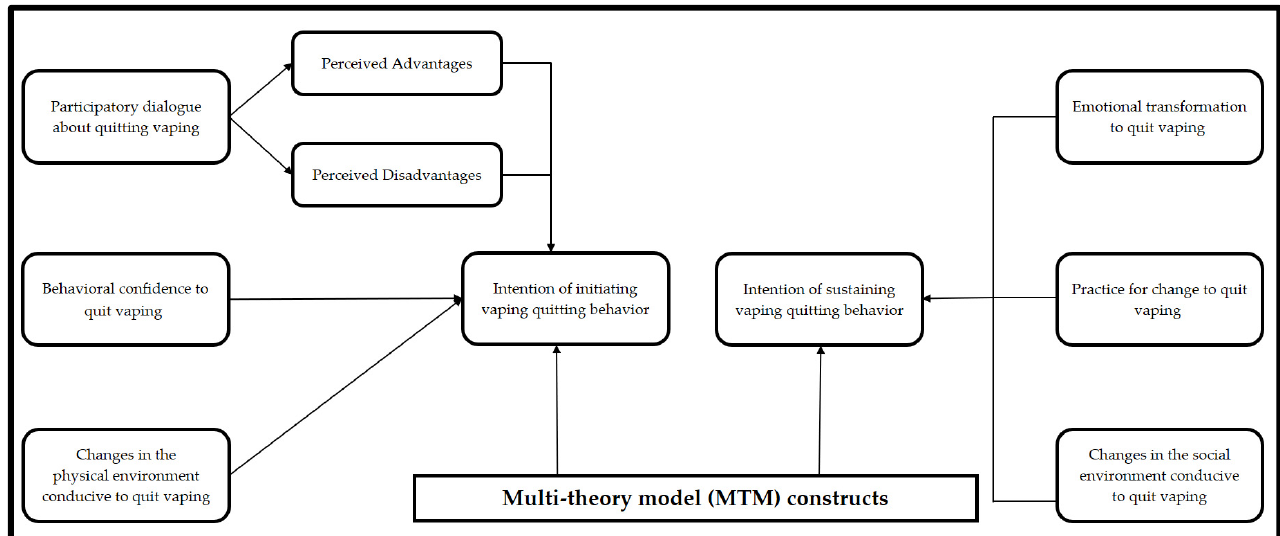
Figure 1. MTM framework used to measure vaping quitting behavior.